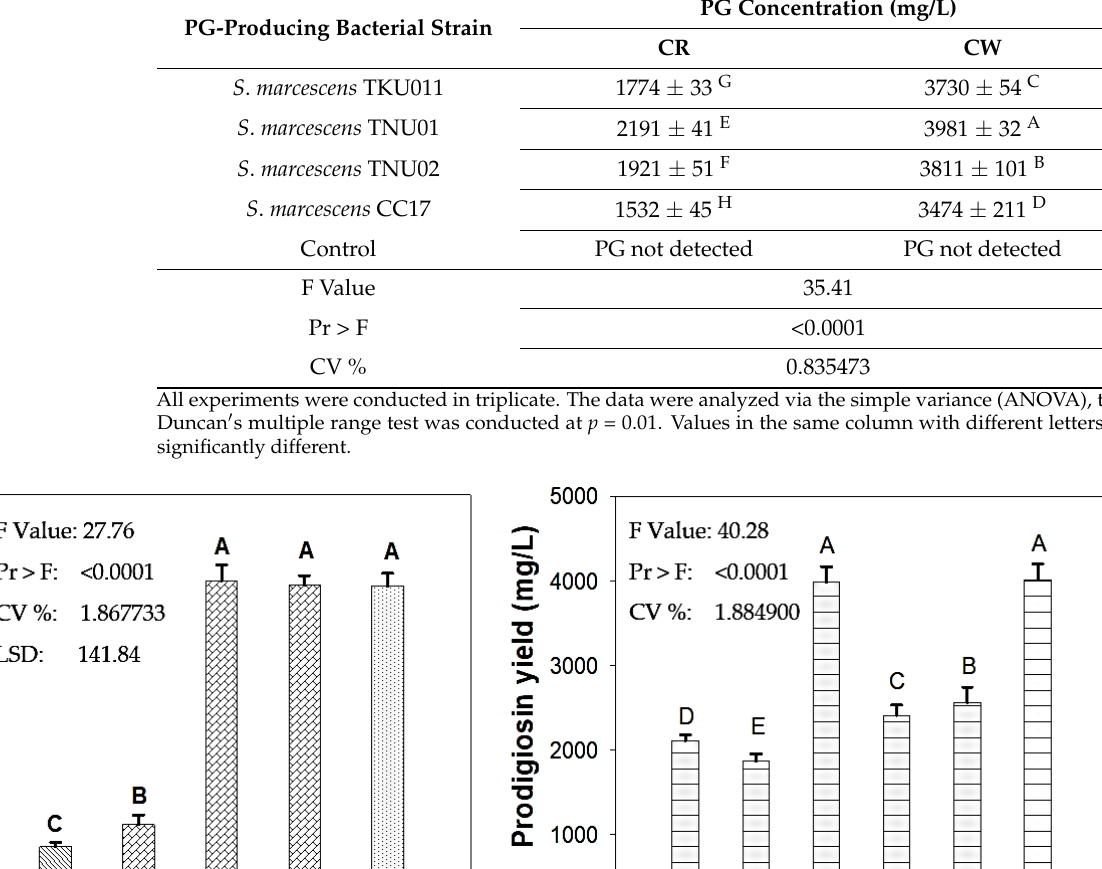
Table 1. Experiments for screening the most suitable PG-producing strain. PG-Producing Bacterial Strain.